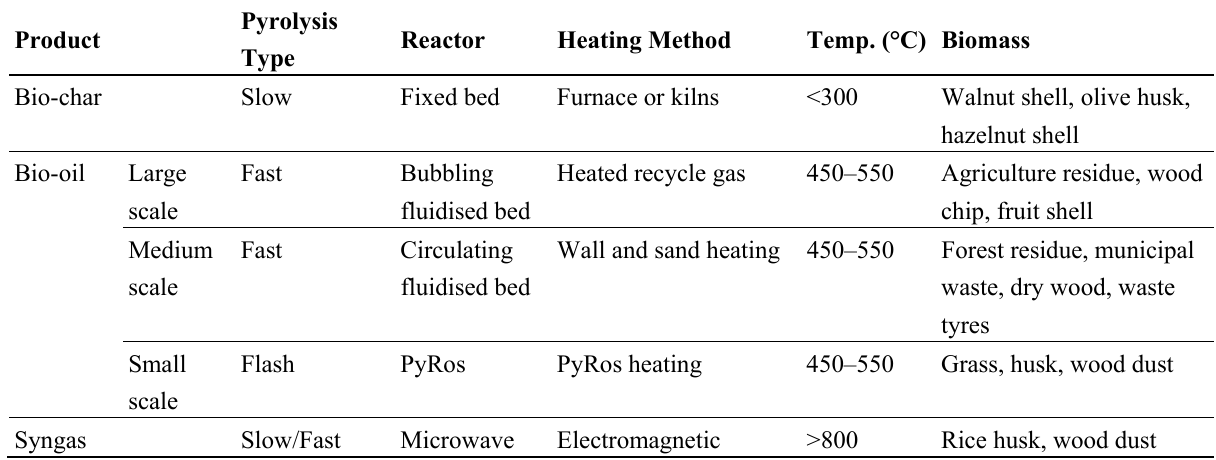
Table 15. Recommended pyrolysis technology according to